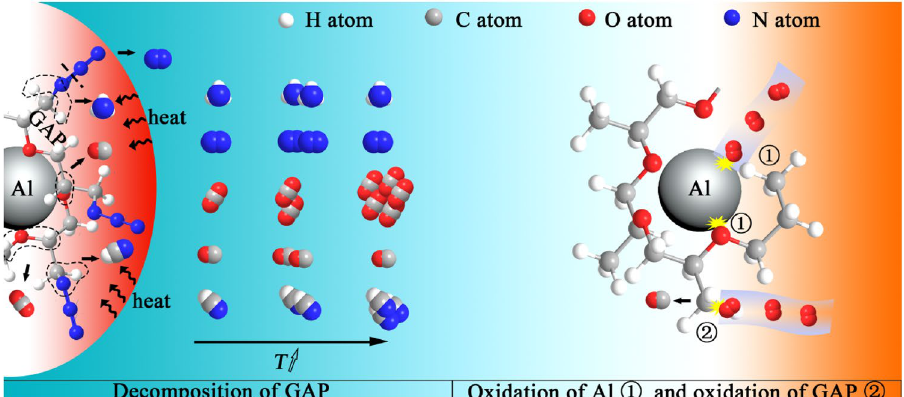
Figure 6. Reaction mechanism illustration of the ALG particles in air.